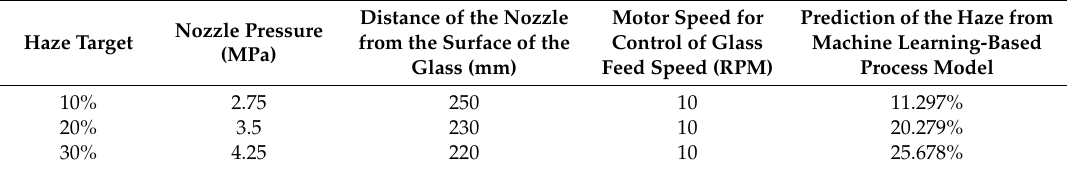
Table 7. Prediction results of the machine running-based process model using process conditions optimized by the statistical process